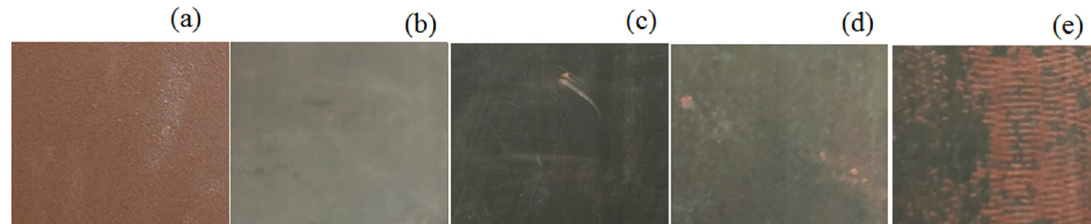
Figure 14. Surface condition under various stand-off distances ( a ) initial state; ( b ) 10 mm; ( c ) 15 mm; ( d ) 20 mm; ( e )25 mm.